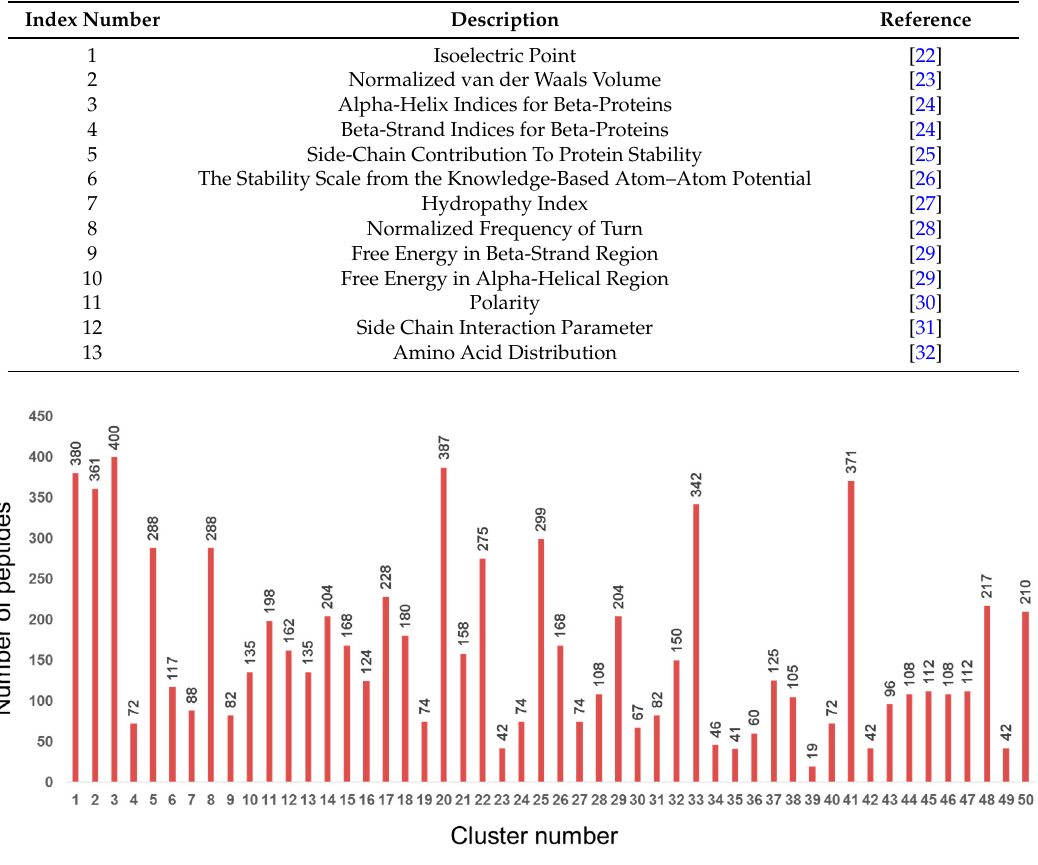
Figure 2. Number of peptides in each of the 50 clusters containing physicochemically similar peptides.